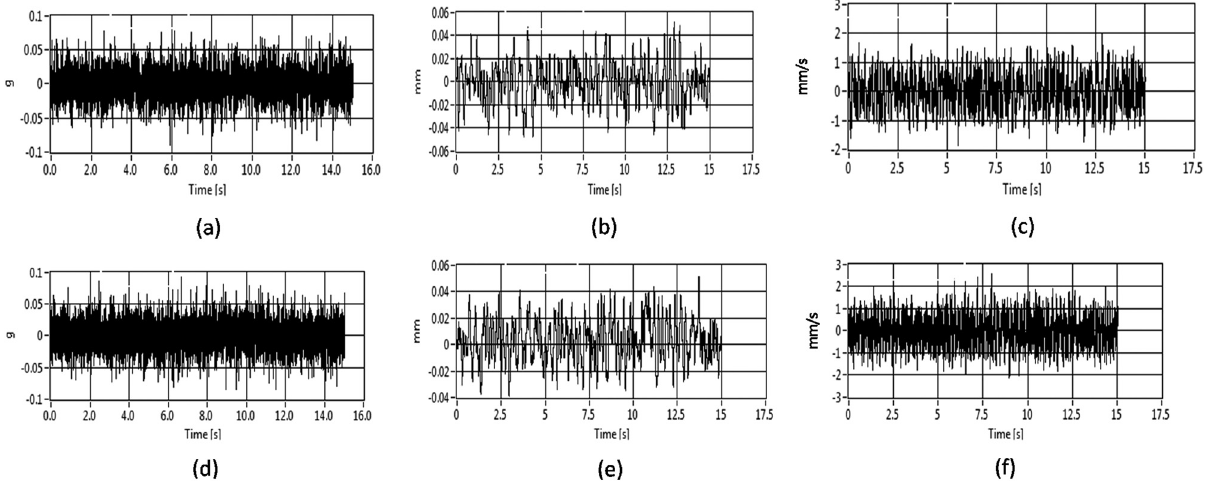
Figure 5: Variation in the amplitude of acceleration, displacement, and velocity with time measured at the surface of foundation embedment ( 0.5H ) . ( a ) Vertical acceleration, az; ( b ) vertical displacement, Az; ( c ) vertical velocity, Vz; ( d ) horizontal acceleration, a displacement, Ay; and ( f ) horizontal velocity, Vy.